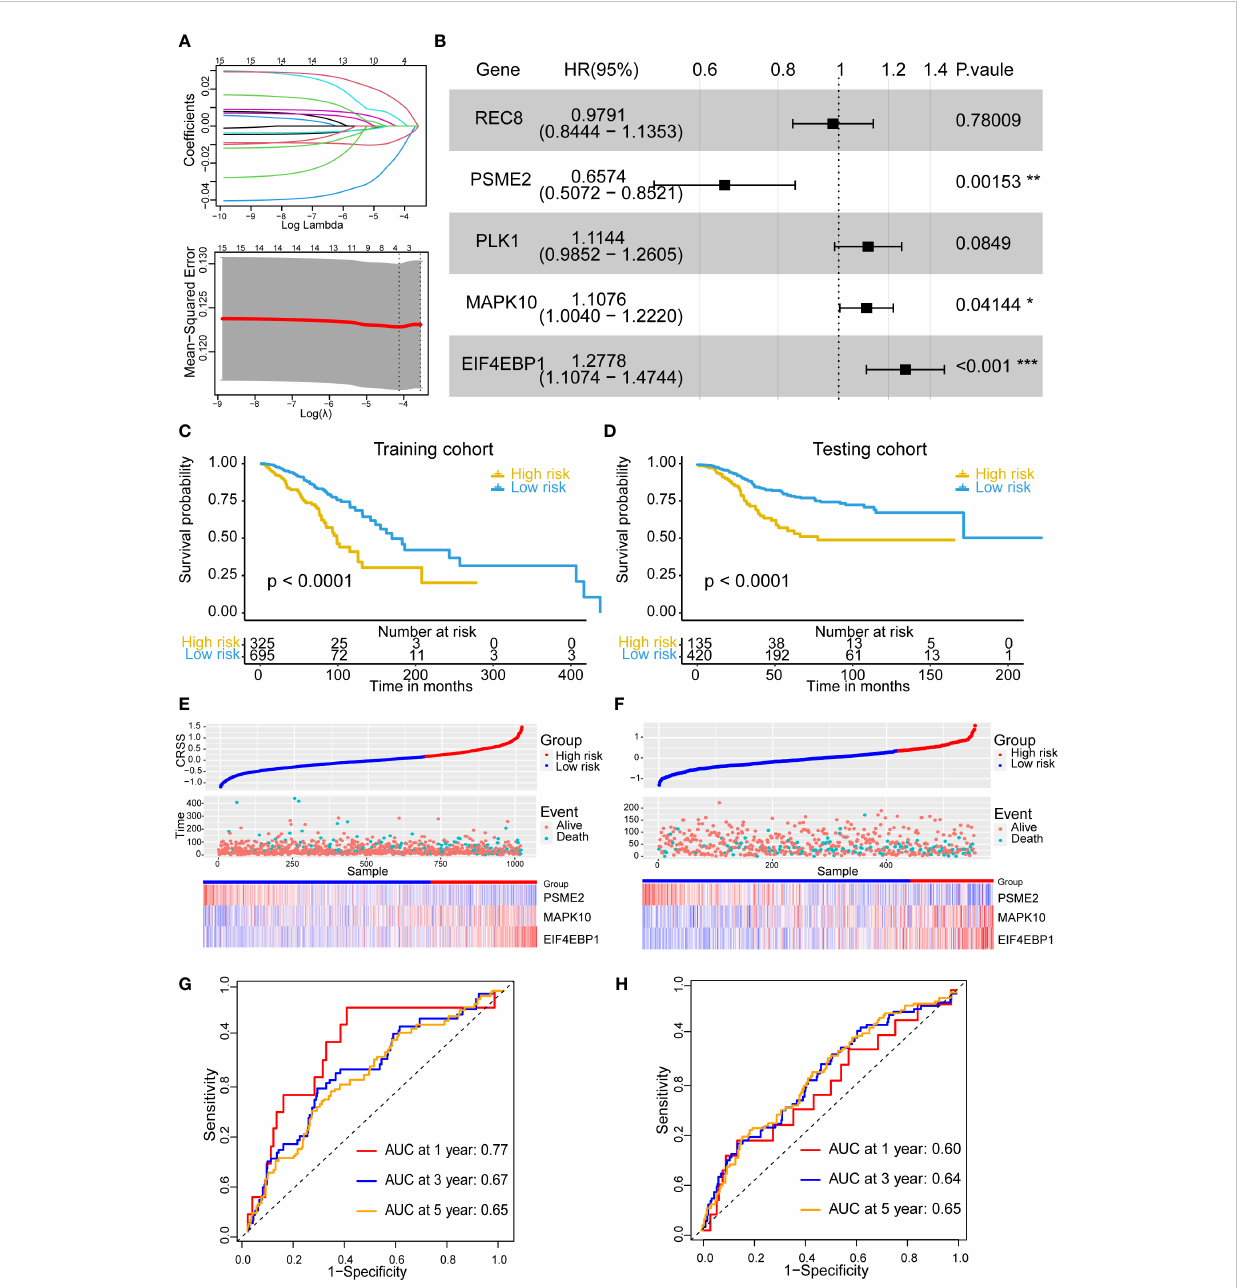
FIGURE 2 Establishment and stability validation of centrosome-related prognostic model. (A) The Least Absolute Shrinkage and Selection Operator (LASSO) Cox regression for the centrosome-related prognostic DEGs. (B) The multivariable Cox regression analysis of fi ve genes based on cross-validation and the minimum partial likelihood deviance to further demonstrate the independent prognosis-related genes and obtain the genes index. (C) Kaplan – Meier analysis for OS curves of patients from TCGA-BRCA in high/low-risk subgroups in training cohort. (D) Kaplan – Meier analysis for OS curves of patients from GEO in high/low-risk subgroups in validation cohort. (E) Distribution of CRSS and patterns of the survival time and survival status between the high/low-risk subgroups for the training set. (F) Distribution of CRSS and patterns of the survival time and survival status between the high/low-risk subgroups for the validation set. (G) Time-related ROC analysis exhibited the prognostic value of the CRSS in the training set. (H) Time-related ROC analysis exhibited the prognostic value of the CRSS in the validation set. The asterisks represent the statistical P value (*p < 0.05; **p < 0.01; ***p <